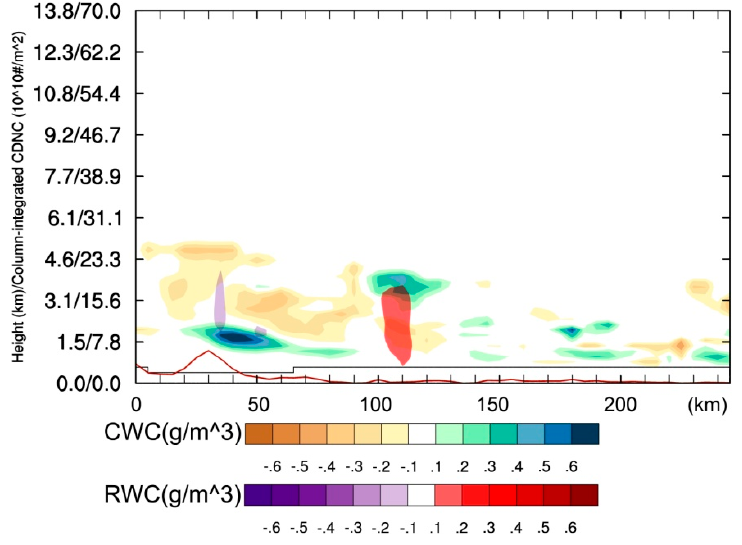
Figure 10. Column-integrated activated CDNC (unit: 10 9 m − 2 ) for 0600 UTC 19 August 2007.